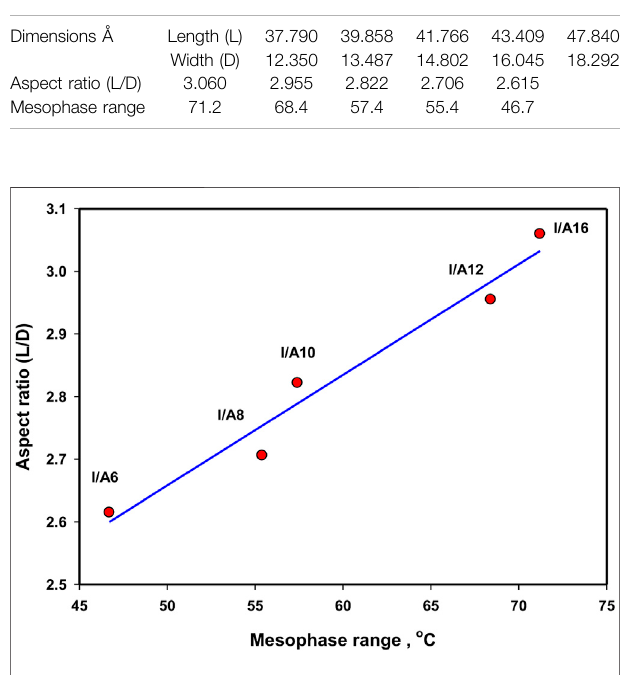
FIGURE 11 | Dependence of the mesophase range with aspect ratio of SMHBCs, I/An.